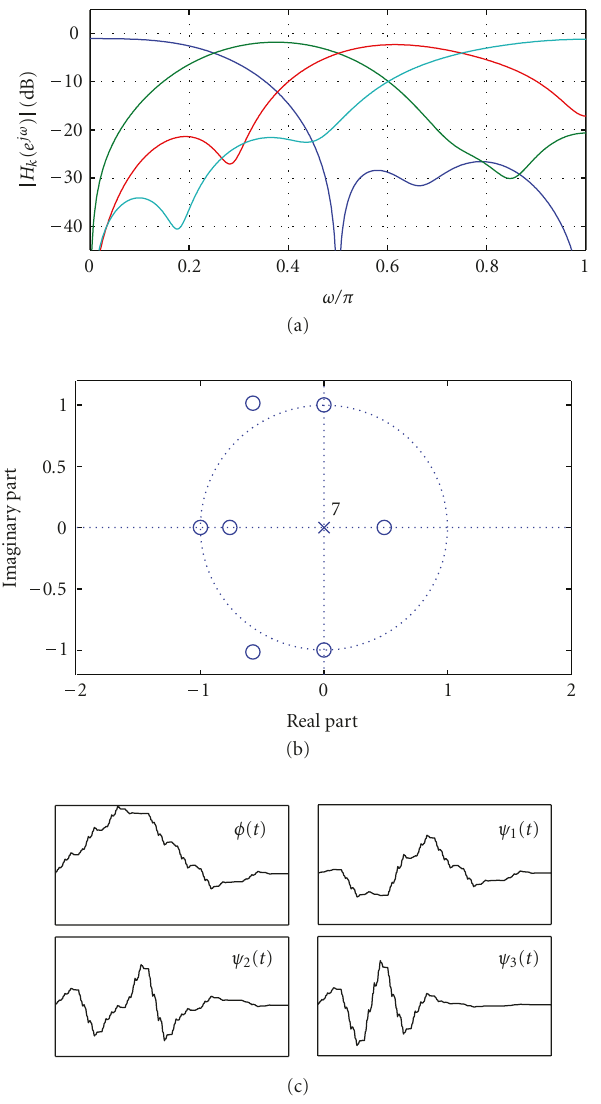
Figure 10: Design example of general PUFB: (a) magnitude re- sponses, (b) zeros of H 0 ( z ), and (c) the scaling function and wavelets.